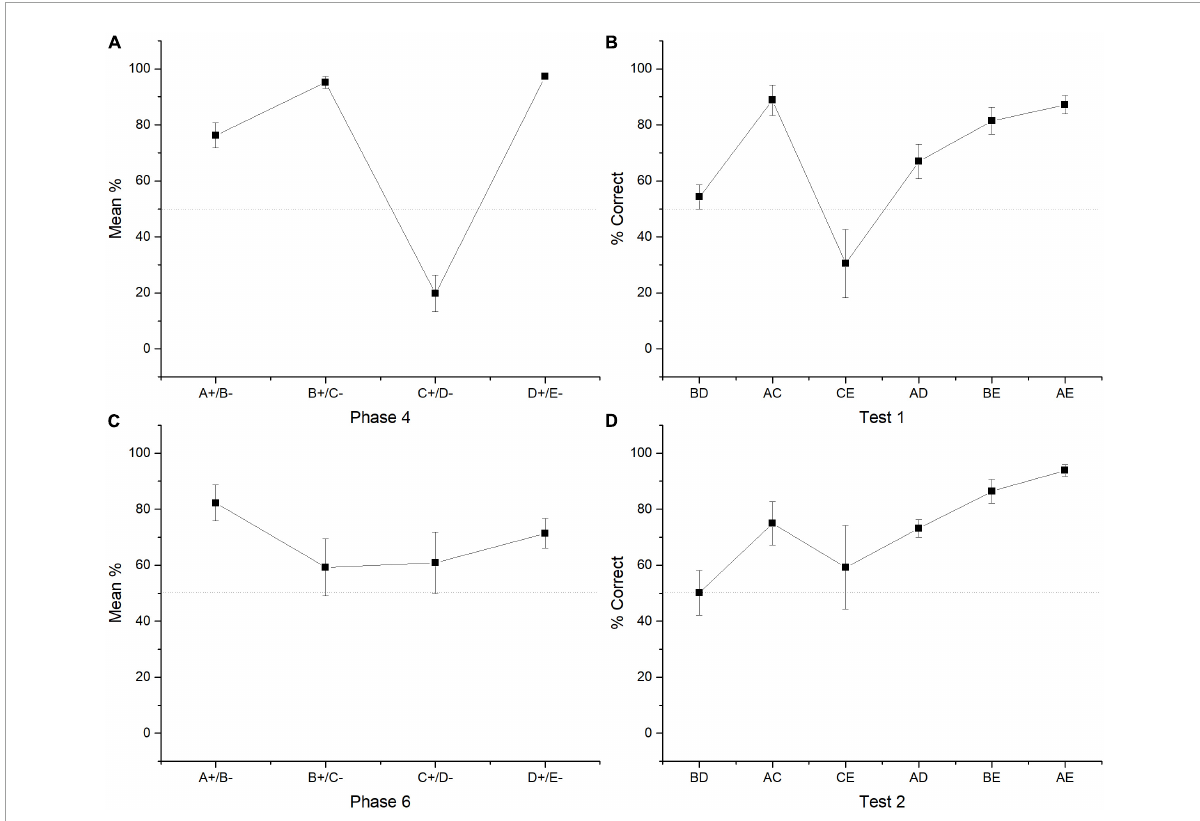
FIGURE2 Mean percentage (SEM ± ) of correct responses for each premise in the last two sessions of phase 4 (A) . Mean percentage (SEM ± ) of correct responses regarding all four sessions of test 2 (B) . Mean percentage (SEM ± ) of correct responses during phase 6 (C) . Mean percentage of correct responses during test 2 (D)